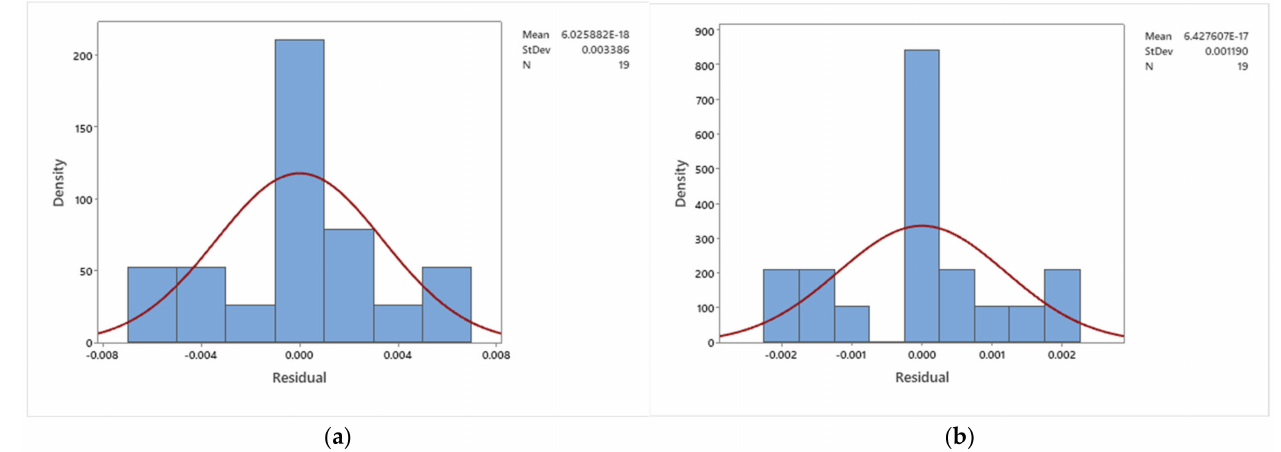
Figure 9. The distribution of residual from ( a ) Re 1/2 x C f and ( b ) Re − 1/2 x Nu x